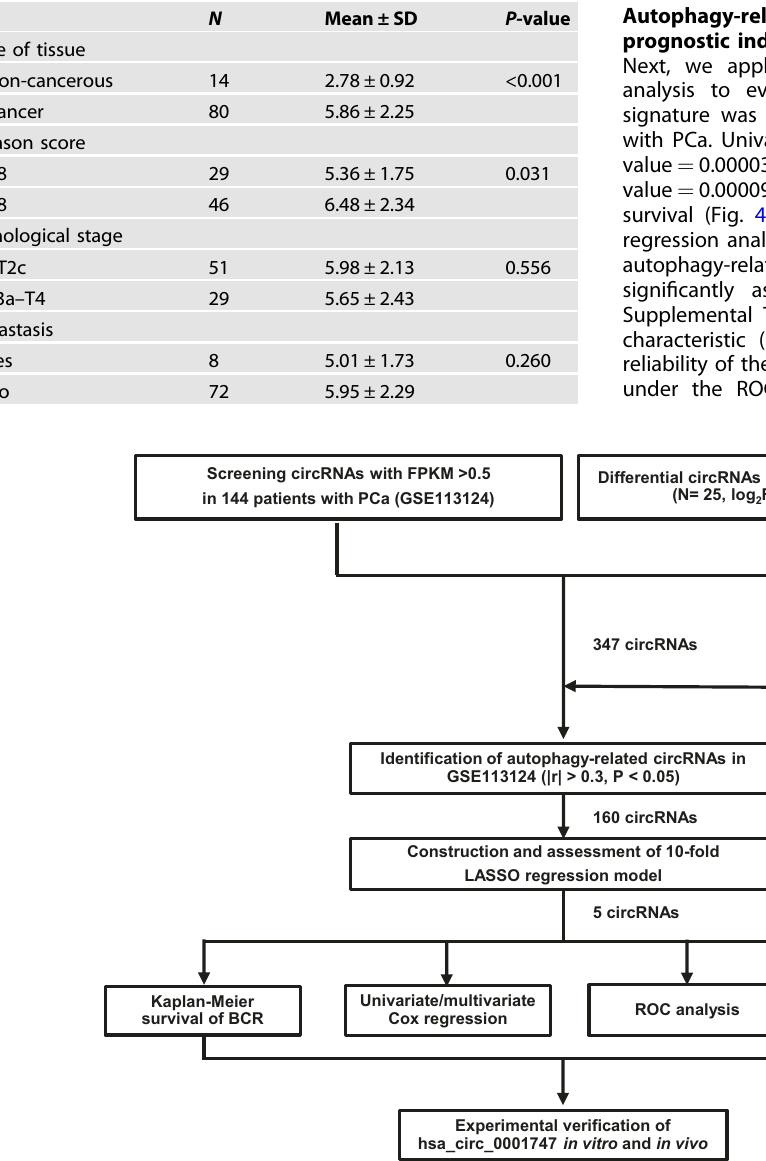
Fig. 2 Flow chart of autophagy-related circRNA signature screening and